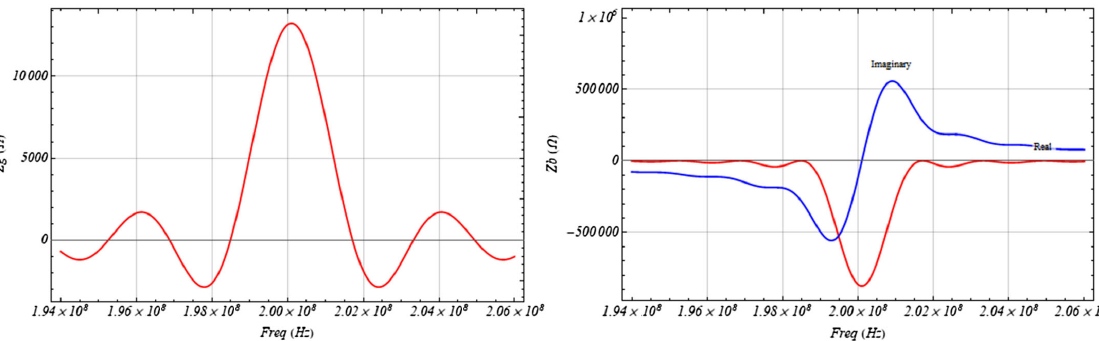
FIG. 3. Four-section cavity. Left: Z